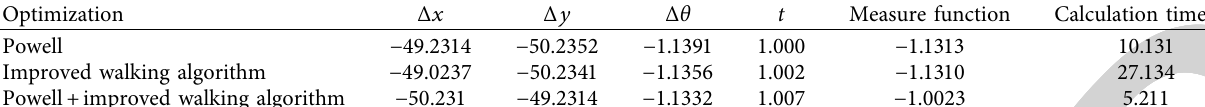
Table 4: Experimental results of the optimization algorithm.